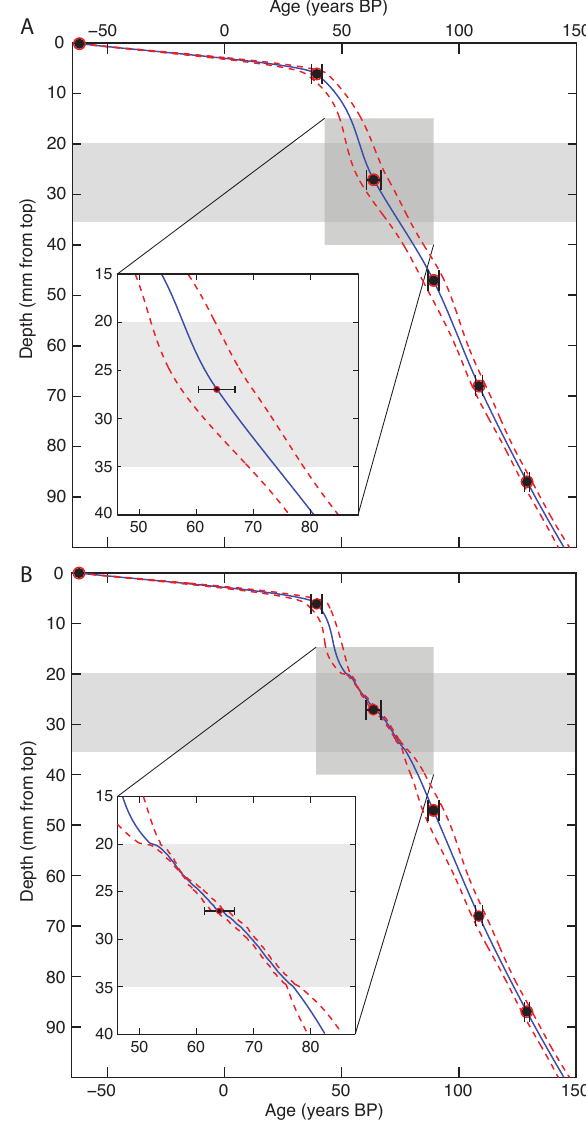
Fig. 10. YOK-G age models without and with layer counted inter- val: (A) the median age model of 2000 MC simulations for YOK-G (in blue) with 95% confidence bounds (in red) without incorpo- rating the layer counted interval. Inset : a detailed view of the age model around the layer counted interval. (B) The median age model for YOK-G (in blue) with 95% confidence bounds (in red) with in- corporation of the layer counted interval. Inset : a detailed view of the age model around the layer counted interval. The increase in the confidence of the age model estimate is clearly visible from a com- parison of the two figures. The confidence bounds were constructed similarly as in Fig.